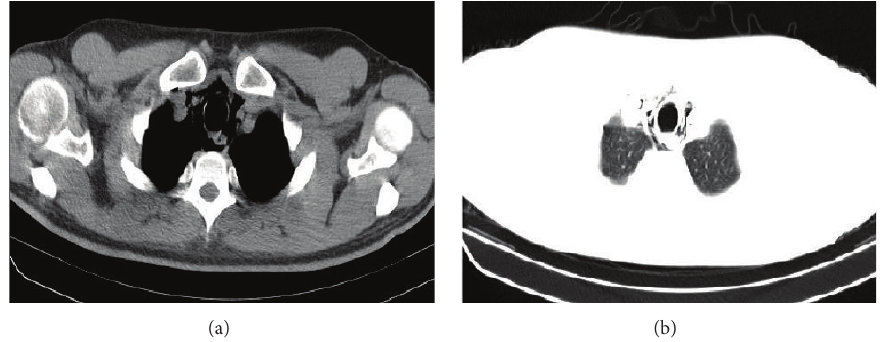
Figure 1: The view of mediastinal emphysema in thorax CT.